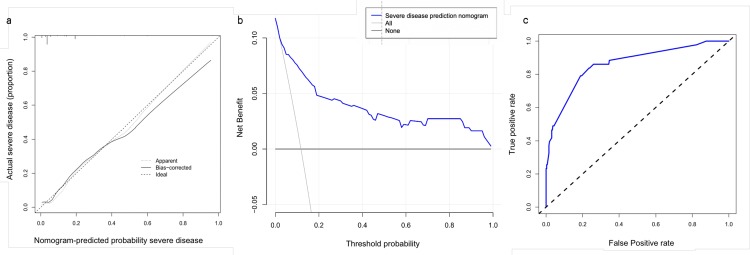
a. Calibration curves of the nomogram for predicting severe COVID-19. Data on predicted and actual disease severity were plotted on the x- and y-axis, respectively. The diagonal dotted line indicates the ideal nomogram, in which actual and predicted probabilities are identical. The solid line indicates the actual nomogram, and a better fit to the dotted line indicates a better calibration. b. Decision curves of the nomogram predicting severe COVID-19. The x-axis represents threshold probabilities and the y-axis measures the net benefit calculated by adding true positives and subtracting false positives. c. Receiver-operating characteristic curve of the nomogram for predicting severe COVID-19.